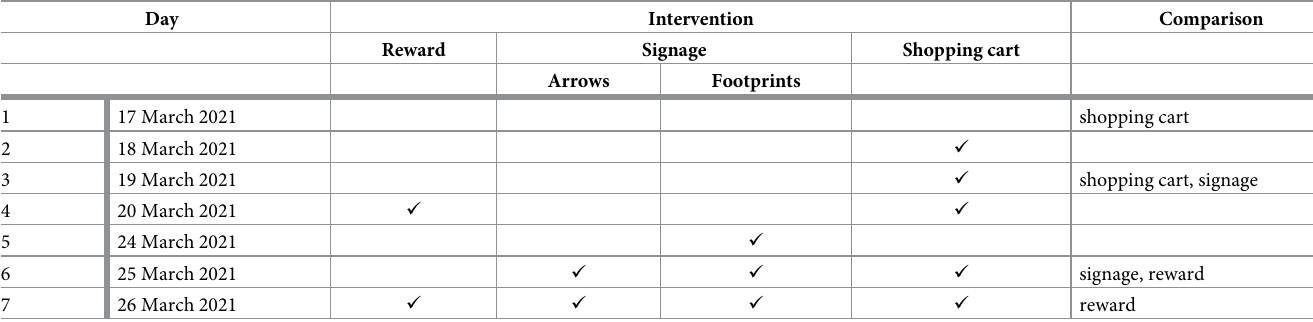
Table 1. Experimental